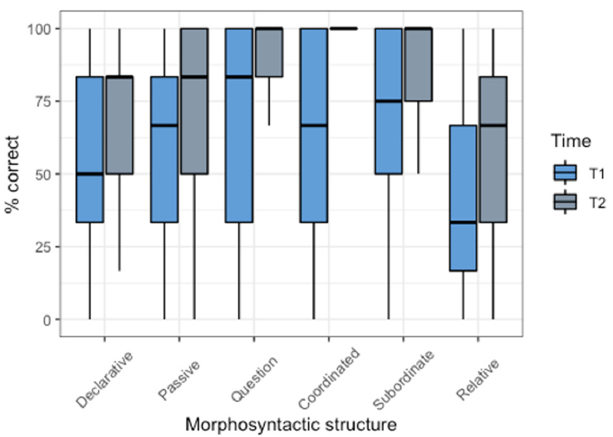
Figure A1. Boxplot of participants’ performance on each structure of the English SRT at T1 and T2. Percentages of correct responses are shown on the y -axis.